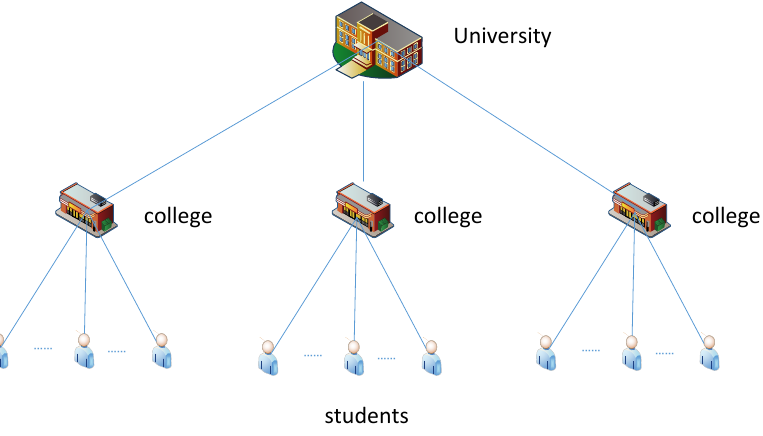
Figure 4. Illustration of vertexes at different levels having different granularity features.